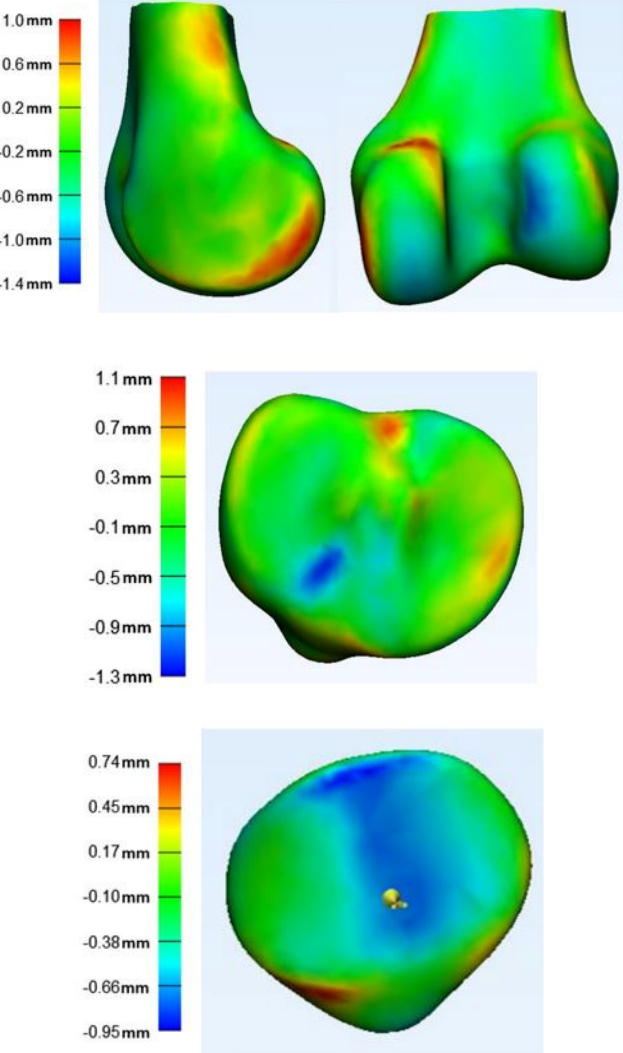
Figure 2. Comparison between average SSMs of the healthy and arthritic bones (femur/tibia/patella). Positive values mean the average arthritic model is larger than the average healthy